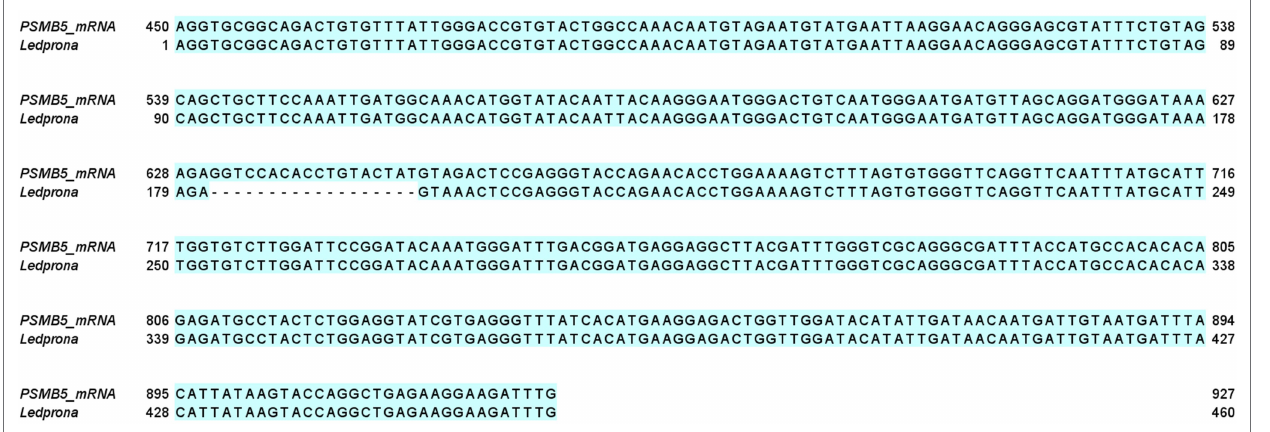
FIGURE 1 | Local alignment between the proteasome subunit beta type-5 messenger RNA (mRNA) and Ledprona sequences performed using EMBOSS